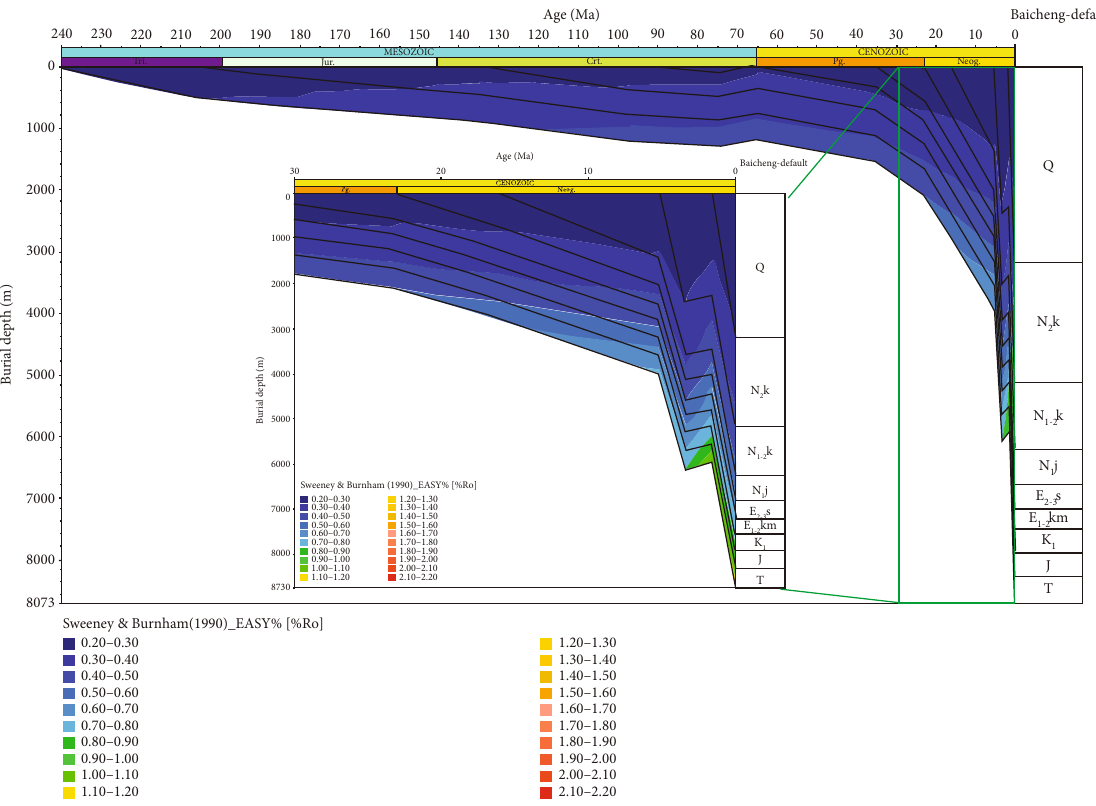
Figure 7: The burial and thermal history of the BC-1 well in the Baicheng Sag